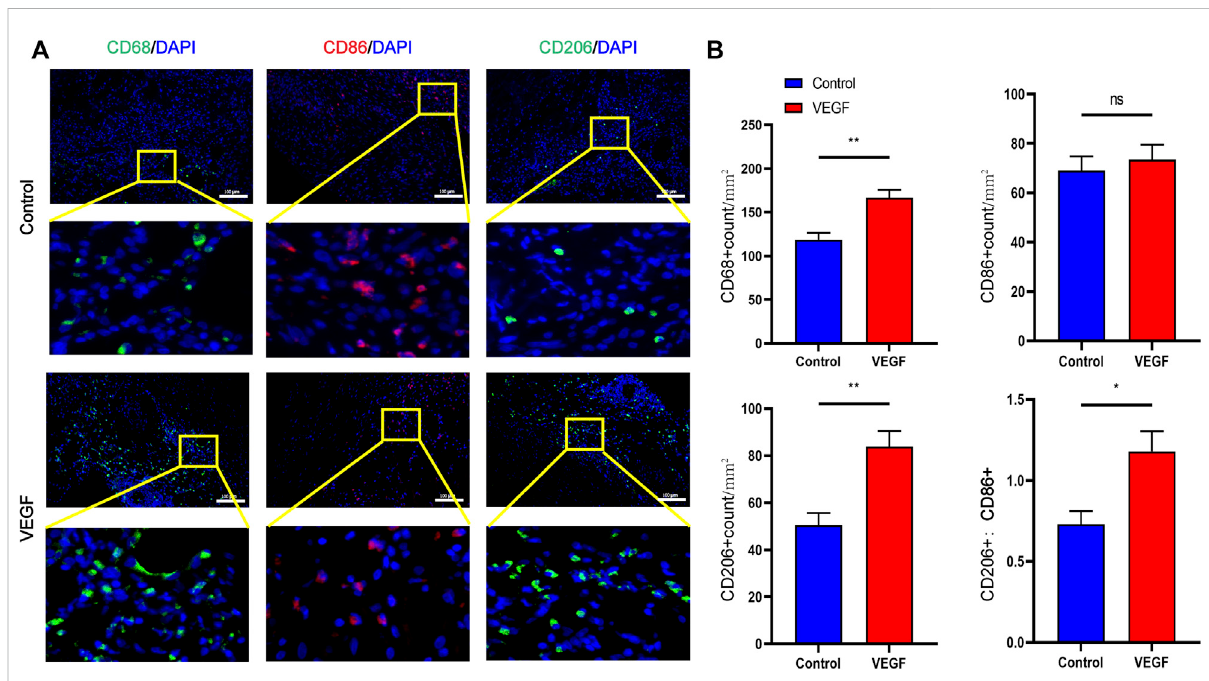
FIGURE 11 Representative immuno fl uorescence images of vascular grafts at day 7 in each group (A) . CD68 and CD206 stained in green, CD86 stained in red. Quanti fi cation of CD68 + total macrophages, CD86 + M1-macrophages, CD206+ M2-macrophages and M2/M1 (CD206+/CD86 + ) ratio (B) . * p < 0.05. ** p < 0.01. ns represents no signi fi cant